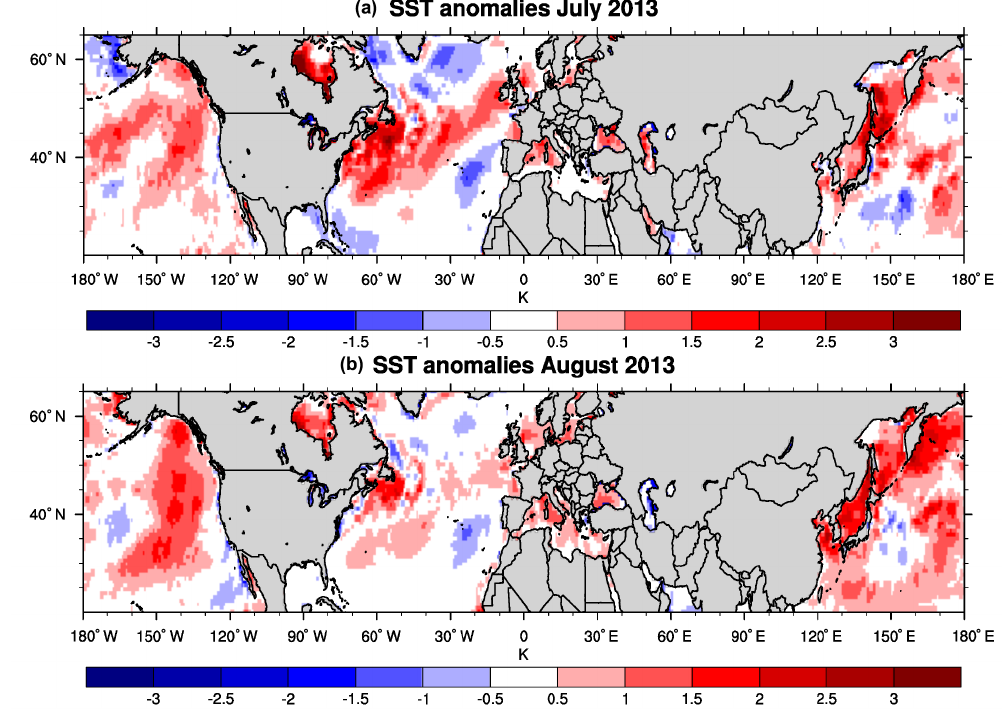
Figure 3. ERA-Interim sea surface temperature (SST) anomalies in July 2013 (a) and August 2013 (b) compared to the climatological period